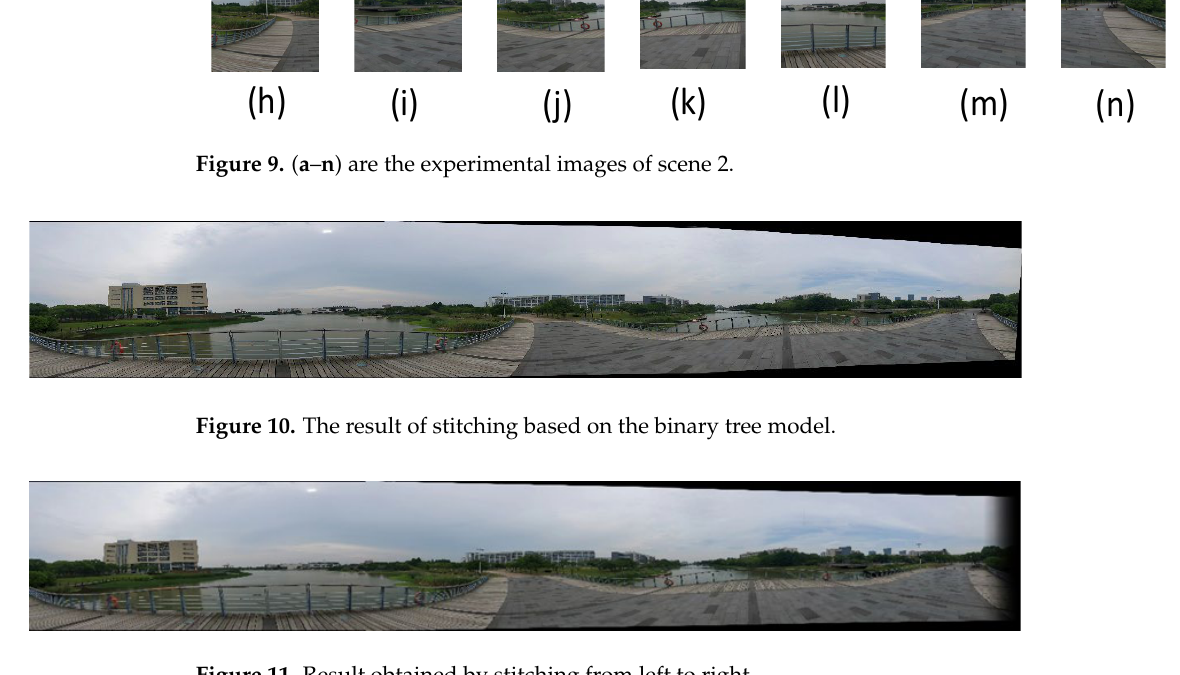
Figure 11. Result obtained by stitching from left to right.